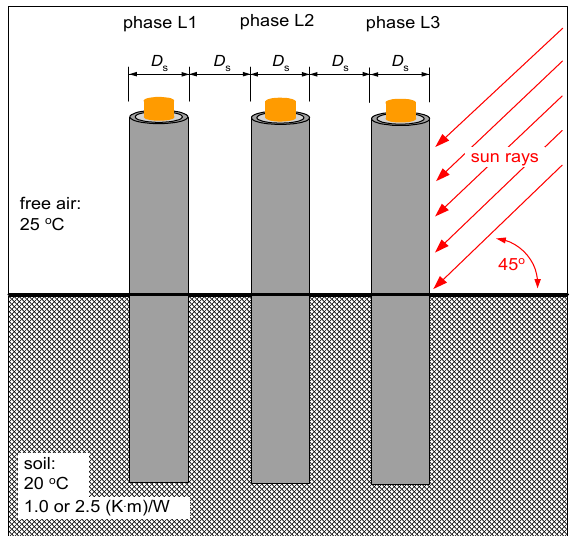
Figure 8. Geometry and boundary conditions of the analyzed power cable line; D s —external diameter of the cable, 1.0 (K · m) / W—the average value of the soil thermal resistivity in many European countries, 2.5 (K · m) / W—unfavourable reference value of the soil thermal resistivity according to [9].